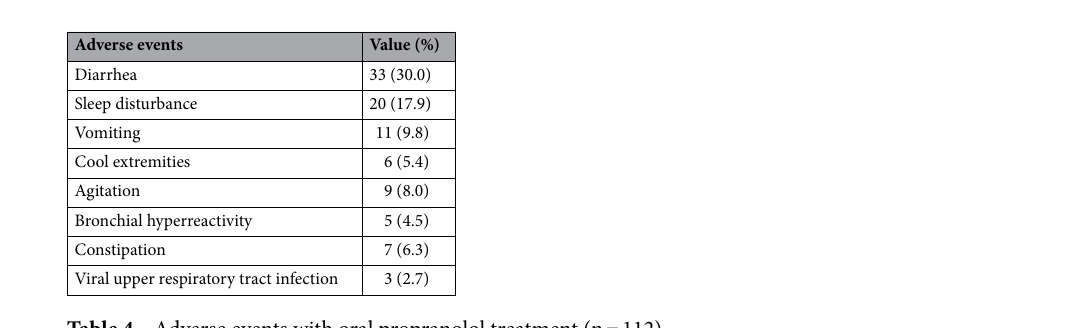
Table 4. Adverse events with oral propranolol treatment (n =